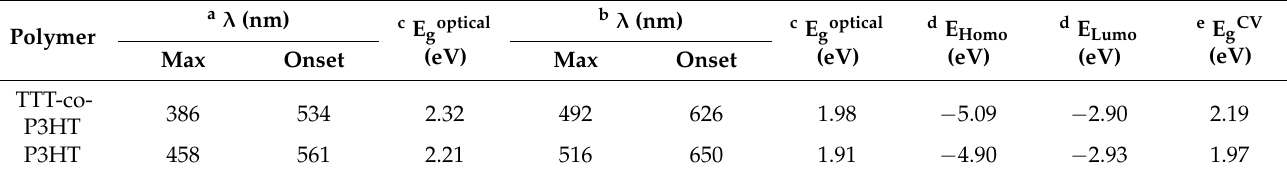
Figure 3. ( A ) Absorption spectra; ( B ) cyclic voltammetry (CV) and ( C ) energy levels diagram of P3HT and TTT-co-P3HT. Table 2. Optical and electrochemical responses of TTT-co-P3HT and P3HT.